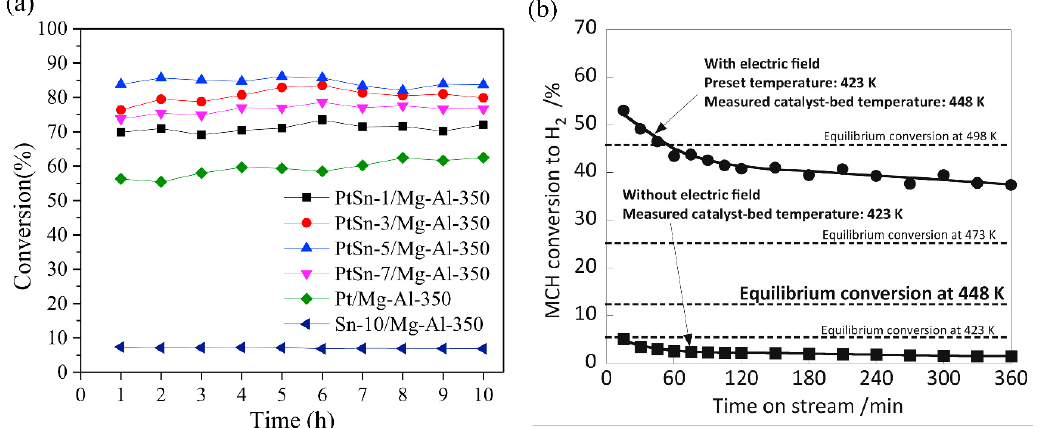
Figure 2. ( a ) MCH conversion on Pt-Sn supported catalysts with different Sn contents Reprinted with permission from [73]. ( b ) Results of catalytic activity tests in the electric field over Pt / anatase-TiO 2 with and without the electric field. Reprinted with permission from [74].